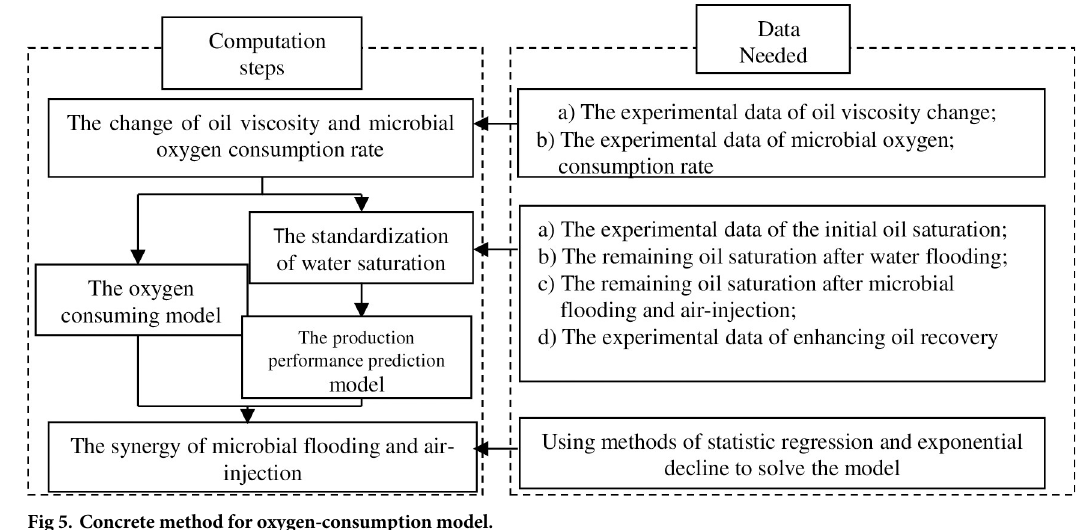
Fig 5. Concrete method for oxygen-consumption